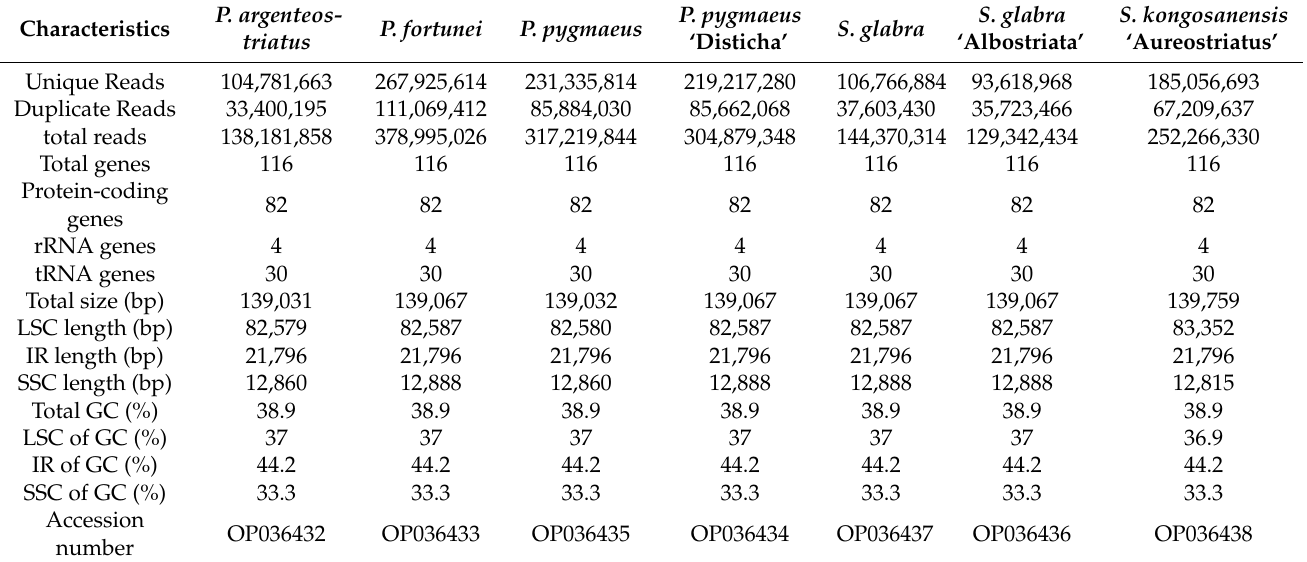
Table 1. Features of the complete chloroplast genomes of seven ornamental bamboo species.